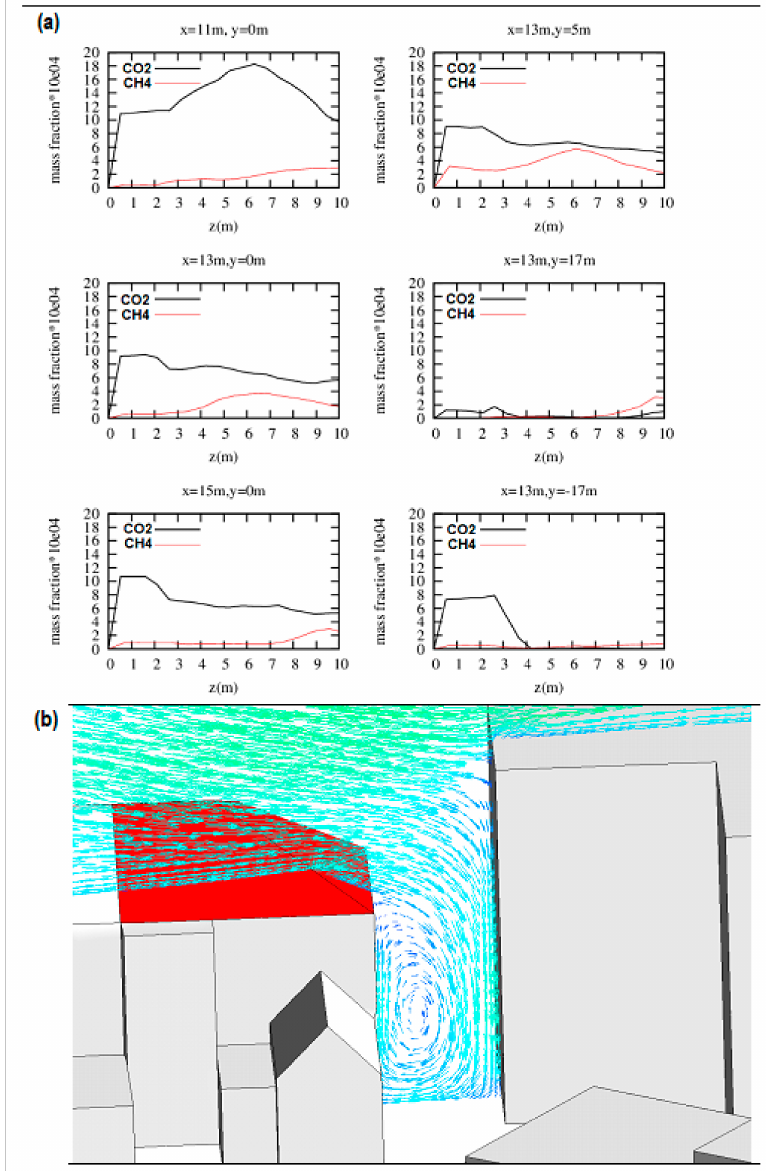
Figure 9. ( a ) CO 2 and CH 4 mass fraction distribution at di ff erent vertical lines, ( b ) vector showing vortex located behind building source (red